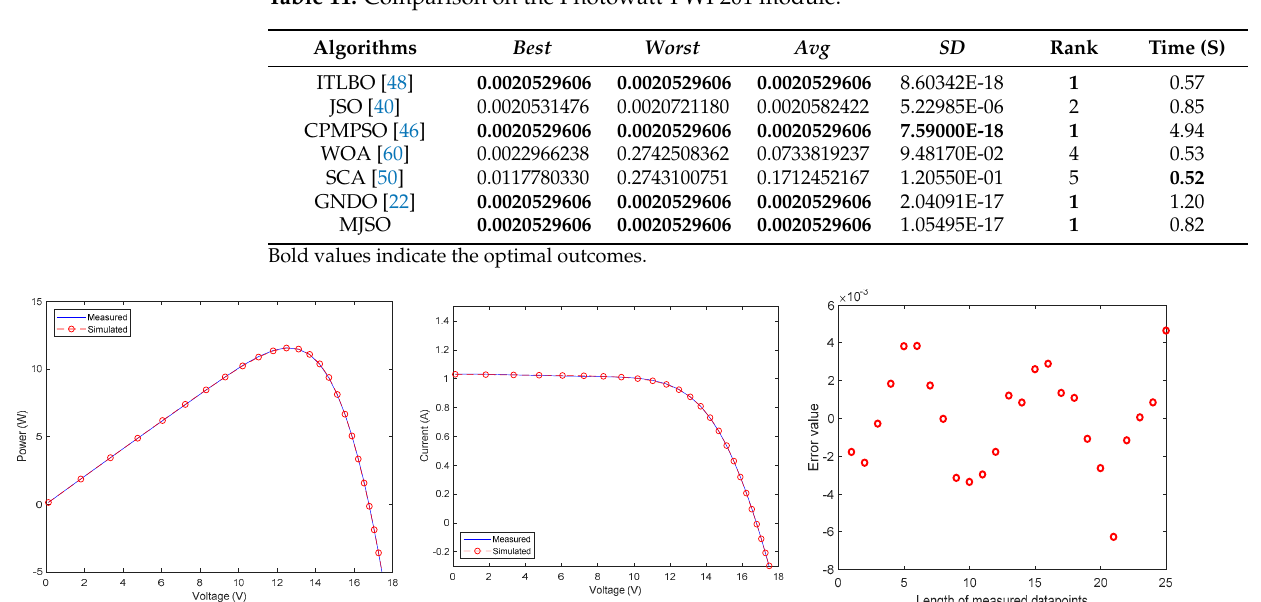
Table 11. Comparison on the Photowatt-PWP201 module.